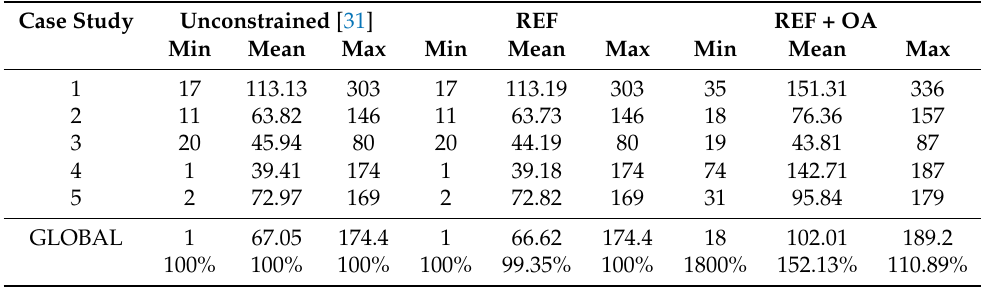
Table 3. Statistics of the number of detections per cluster for the unconstrained system [31], the system with reprojection error filtering (REF), and the system with reprojection error filtering and orientation alignment (REF +